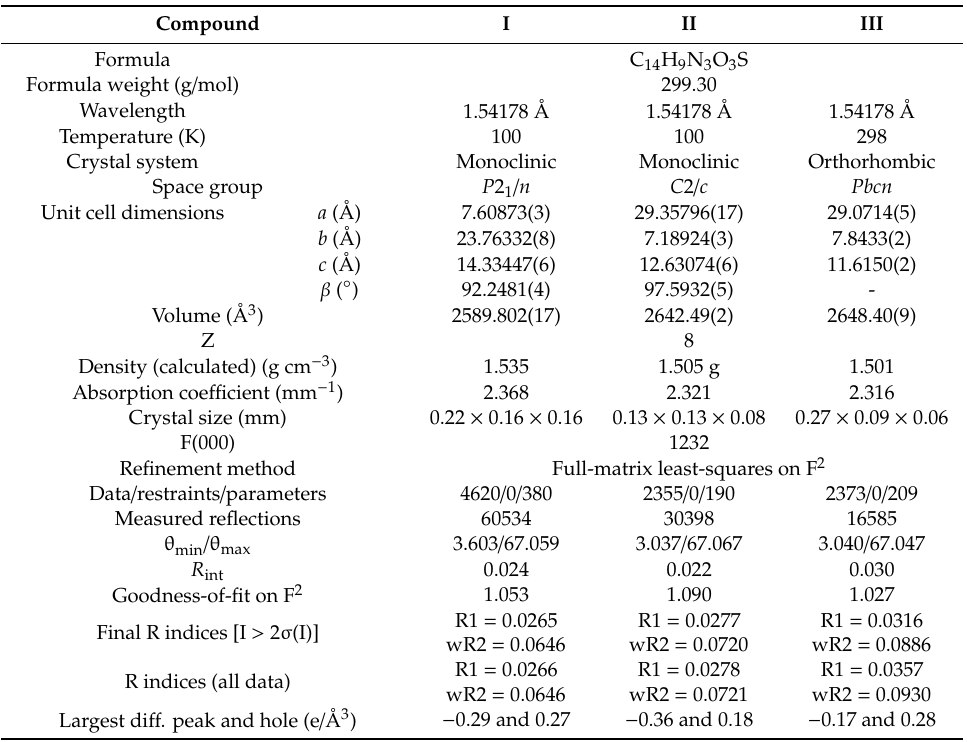
Table 2. Crystal data and structure refinement parameters for I, II and III.